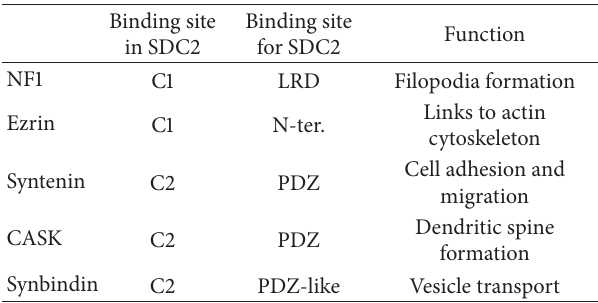
Table 1: SDC2 interacting